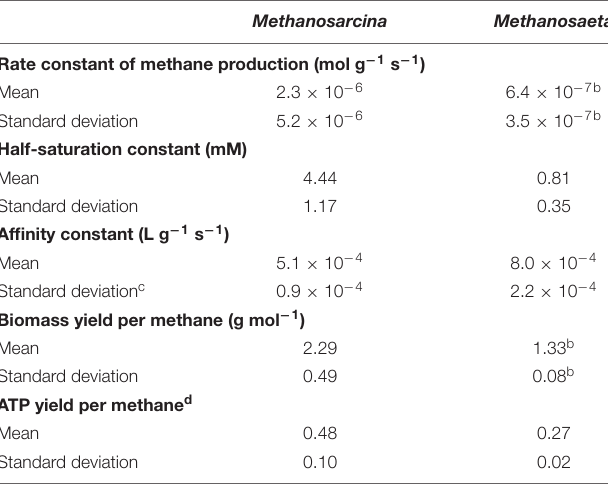
TABLE 1 | Mean and standard deviation of kinetic and thermodynamic parameters of mesoneutrophilic Methanosarcina and Methanosaeta laboratory cultures. a